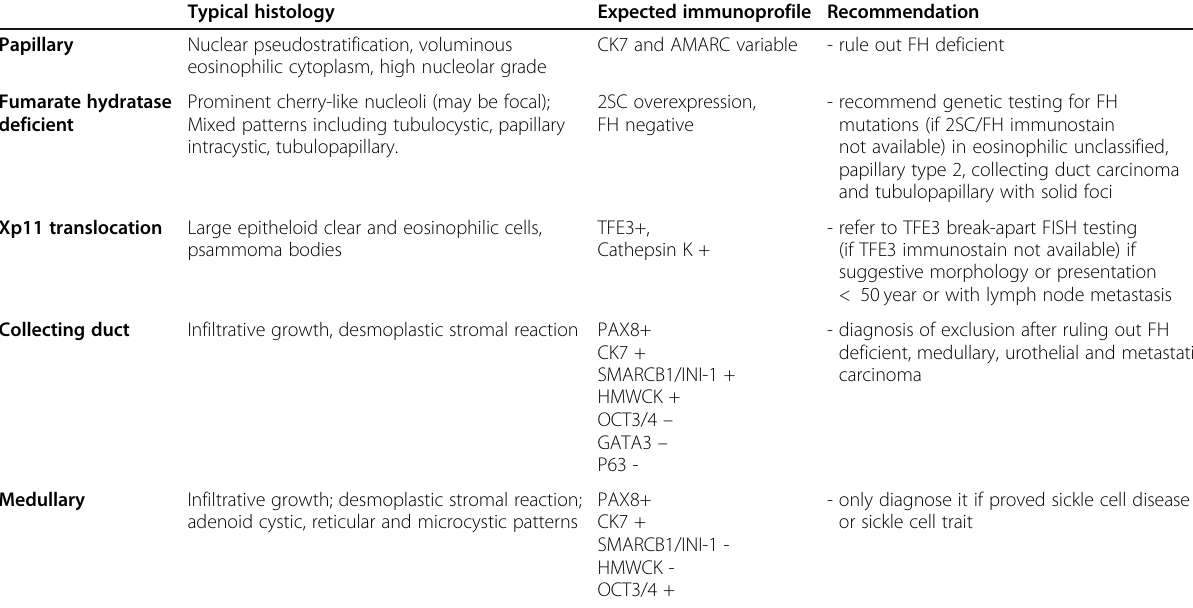
Table 3 Papillary tumors, with predominant eosinophilic cells Typical